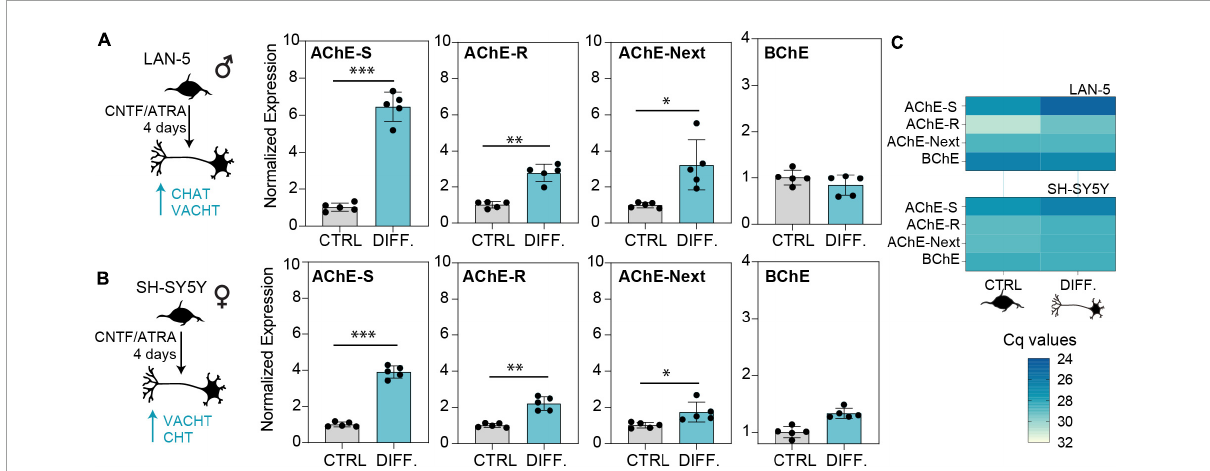
FIGURE5 Cholinergic differentiation of neuroblastoma cell lines elevates the levels of AChE-S, AChE-R, and AChE-Next, but not BChE transcripts. Cholinergic differentiation induced by 4 days of treatment with CNTF and ATRA led to elevation of cholinergic markers CHAT, SLC18A3 (VAChT), and SLC5A7 (CHT) ( Supplementary Figure 1 ). (A) Specifically, LAN-5 cells showed upregulation of all AChE variants (AChE-S, p -value < 0.0004; AChE-R, p -value < 0.004, AChE-Next, p -value < 0.02). (B) SH-SY5Y cells showed upregulated AChE-S ( p -value < 0.0001), ACHE-R ( p < 0.01), and ACHE-Next ( p < 0.05). BChE mRNA levels remained unchanged in both cell lines. (C) RT-qPCR Cq values show the predicted predominance of AChE-S over BChE or AChE-R and AChE-Next transcripts in cholinergic-differentiated LAN-5 and SH-SY5Y cells. Normalized